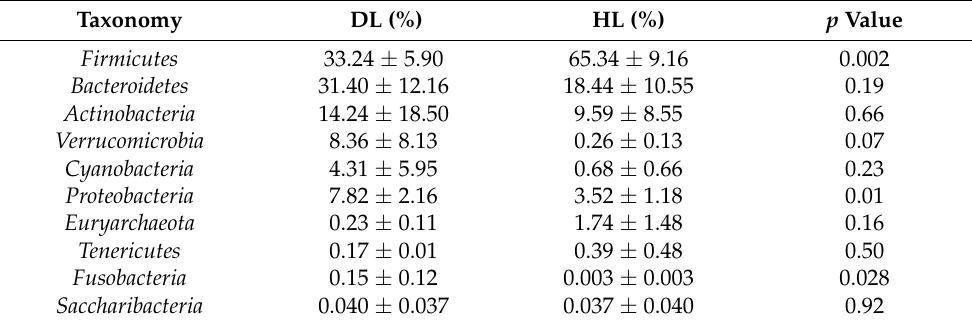
Table 1. Comparison of top 10 phyla in the feces of kids with diarrhea (DL, n = 3) and healthy kids (HL, n = 6) at day 0.